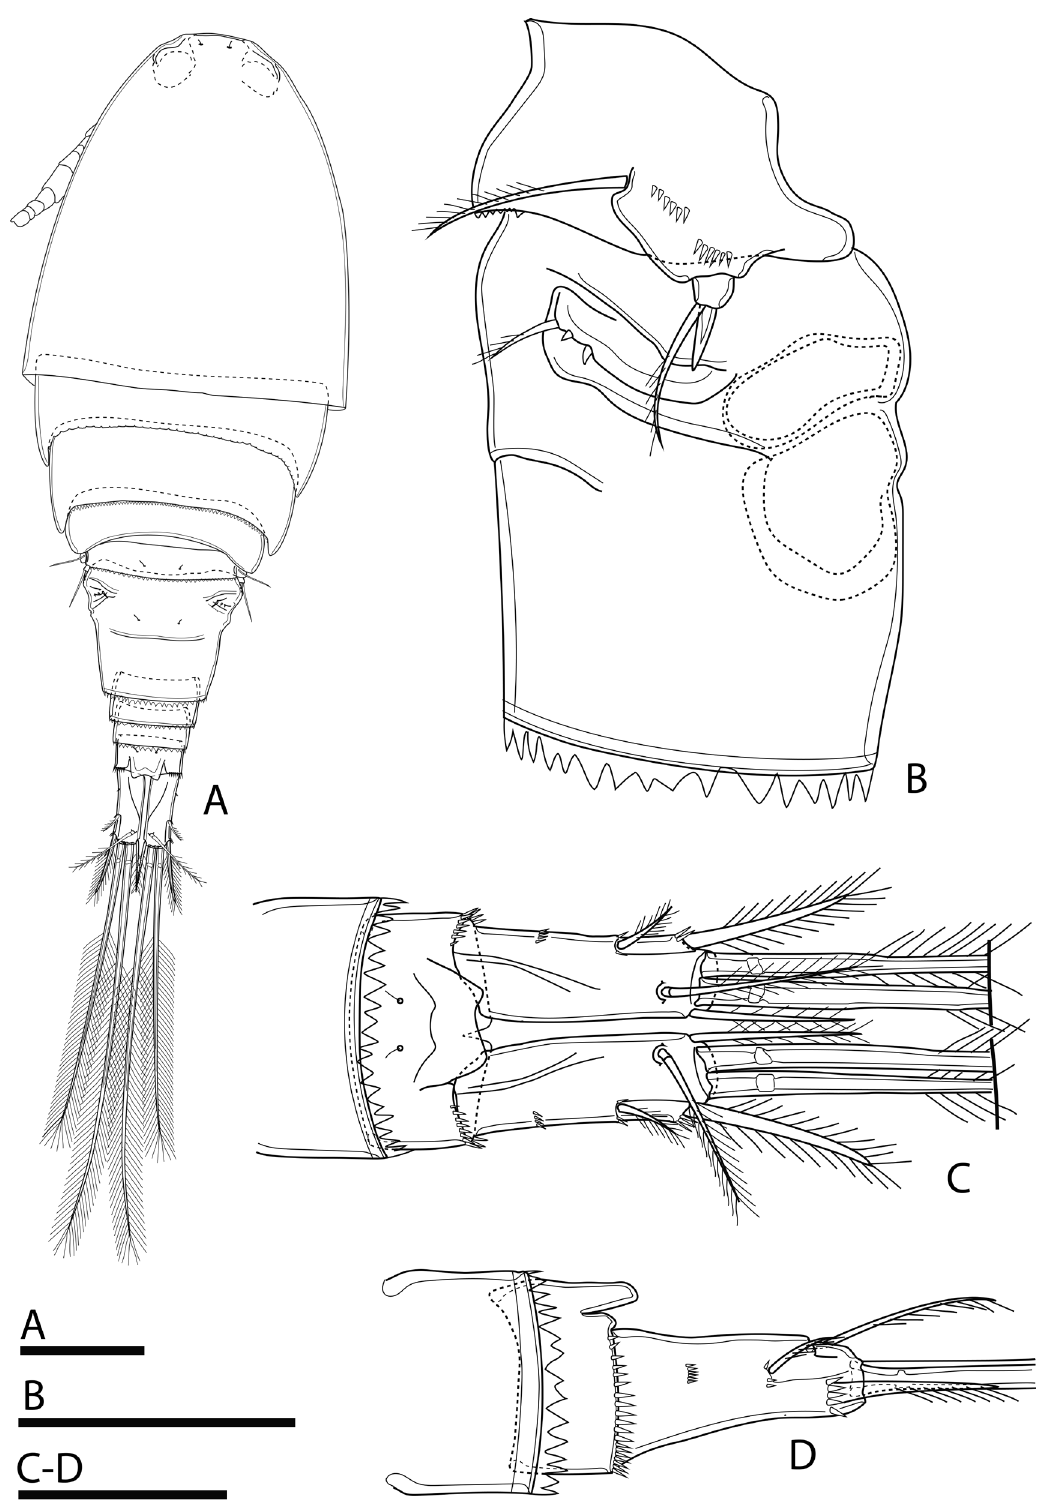
Fig. 10. Metacyclops brancelji sp. nov., paratype, ♀ (A; ZMB 34231a) and holotype, ♀ (B−D; ZMB 34231 slide No. 5124). A . Habitus, dorsal view. B . Fifth pedigerous somite and genital double-somite, lateral view. C−D . Two last abdominal somites and caudal rami, dorsal and lateral views, respectively. Scale bars: A = 100 μm; B−D = 50